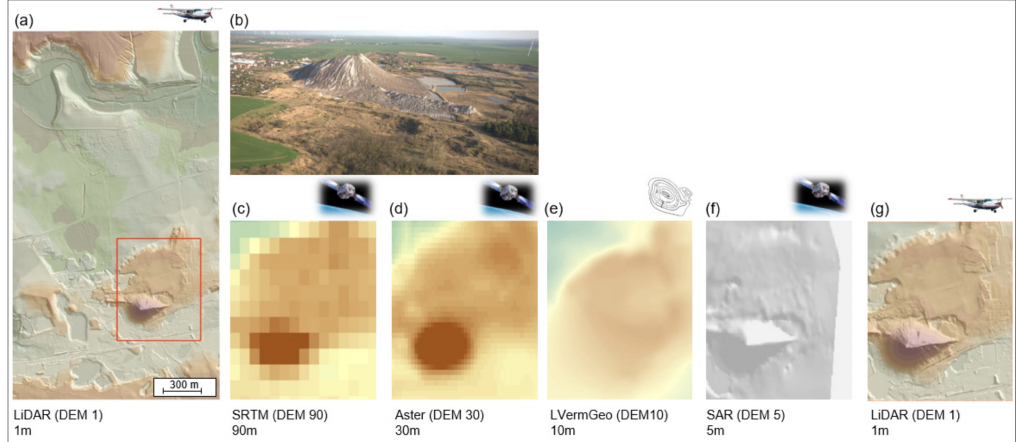
Figure 9. For discrimination and successful monitoring, in addition to the characteristics and the distribution of geomorphic traits and their changes, the spatial characteristics of the deployed RS sensors are of major importance. Here the importance of the spatial resolutionis illustrated through a comparison of DEMs of a post-mining potash tailings pile, Teutschenthal-Bahnhof, near Halle, Germany (see also Schwefel et al. [94]): ( a ) LiDAR (DEM 1)—1 m, ( b ) photo of the post-mining landscape with the 95 m high potash tailings pile, ( c ) SRTM (DEM 90)—90 m, ( d ) Aster (DEM 30)— 30 m, ( e ) DEM generated from height information of the land surveying office—LVermGeo (DEM 10)— 10 m, ( f ) SAR (DEM 5)—5 m, ( g ) LiDAR (DEM 1)—1 m (from Lausch et al.